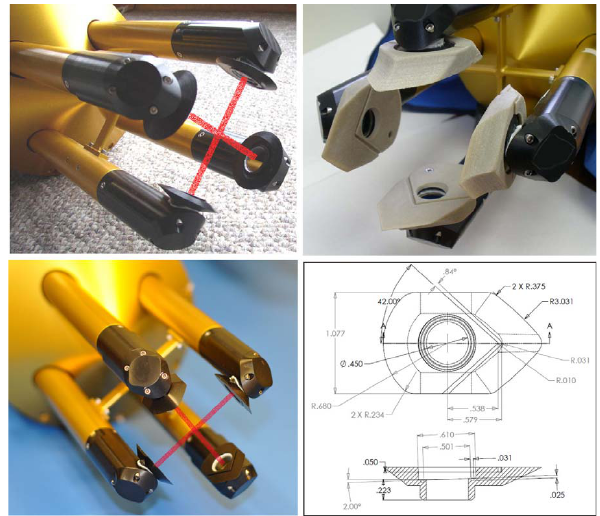
Figure C.1. (top left) Photograph of “standard” (unmodified) 2D-S probe tips used in ISDAC and by the standard probe in SPARTICUS. (upper right) Photograph of 2D-S probe with adapter tips fitted onto the standard probe arms, which was used in the AIIE field campaign and by the modified probe during SPARTICUS (note that the outer surfaces of the adapter tips have rime ice on them). (lower left) Photograph of the 2D-S probe tips that are designed based on the adapter tips shown at the upper right, but are integrated with the 2D-S probe arms; these tips were used in the MACPEX project. (lower right) Engineering drawing showing shape and dimensions of the modified probe tips.